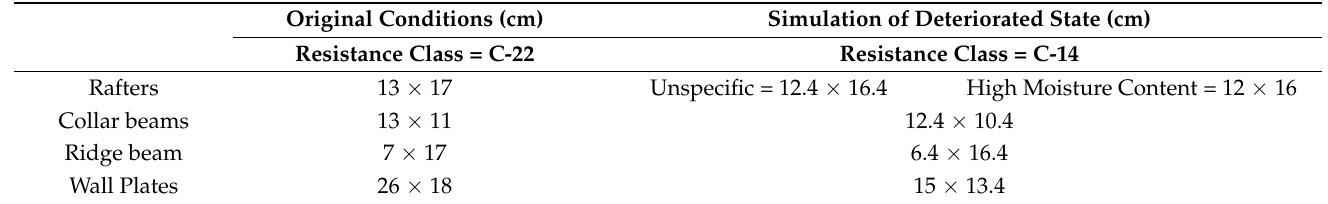
Table 5. Conditions and dimensions of the structure beams. Original state and deteriorated simulation